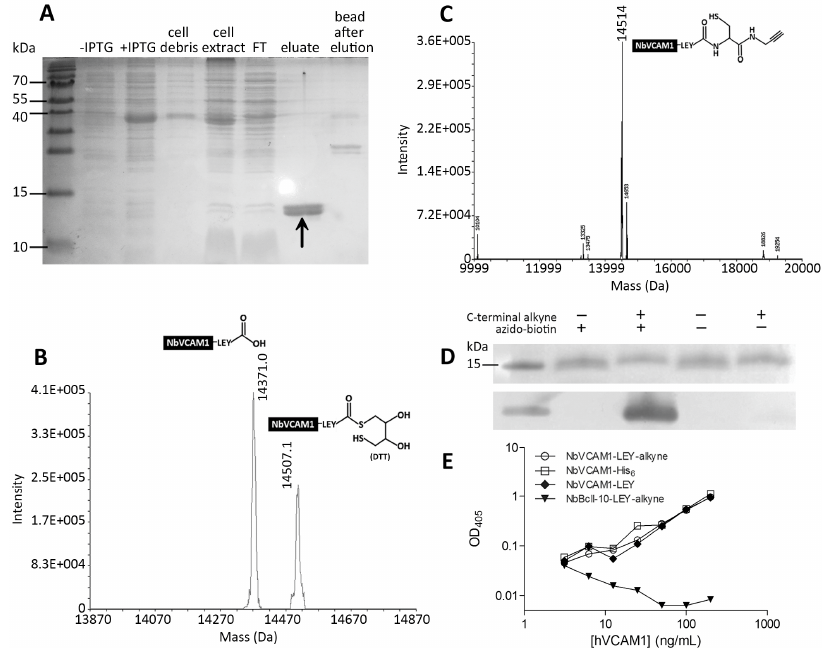
Figure 1. ( A ) SDS-PAGE of cytoplasmic expression and purification steps of NbVCAM1-LEY-alkyne during the EPL process. From left to right: non-induced and Isopropyl β -D-1-thiogalactopyranoside--induced total cell proteins, the cell debris and lysate, the proteins not bounded to the chitin column (FT: flow through), the eluted fraction (alkynated NbVCAM1-LEY) (arrow) and the extract of the beads after EPL. ( B , C ) Mass spectra of the purified NbVCAM1-LEY and NbVCAM1-LEY-alkyne fractions, respectively, with their structures. ( D ) CuAAC-mediated biotinylation of NbVCAM1-LEY-alkyne and analysis by SDS-PAGE (top) and Western blot (bottom), demonstrating the presence of the alkyne “click” function. ( E ) Sandwich ELISA to show the hVCAM1 antigen binding capacity of different nanobody variants. The experiment was performed in triplicate and the data are plotted on a log-log scale. The non-alkynated, fully active NbVCAM1-His 6 and the NbBcII-10-LEY-alkyne (will not bind VCAM1—see Supplementary Materials for more details about the production of these nanobodies) are used as positive and negative controls, respectively.